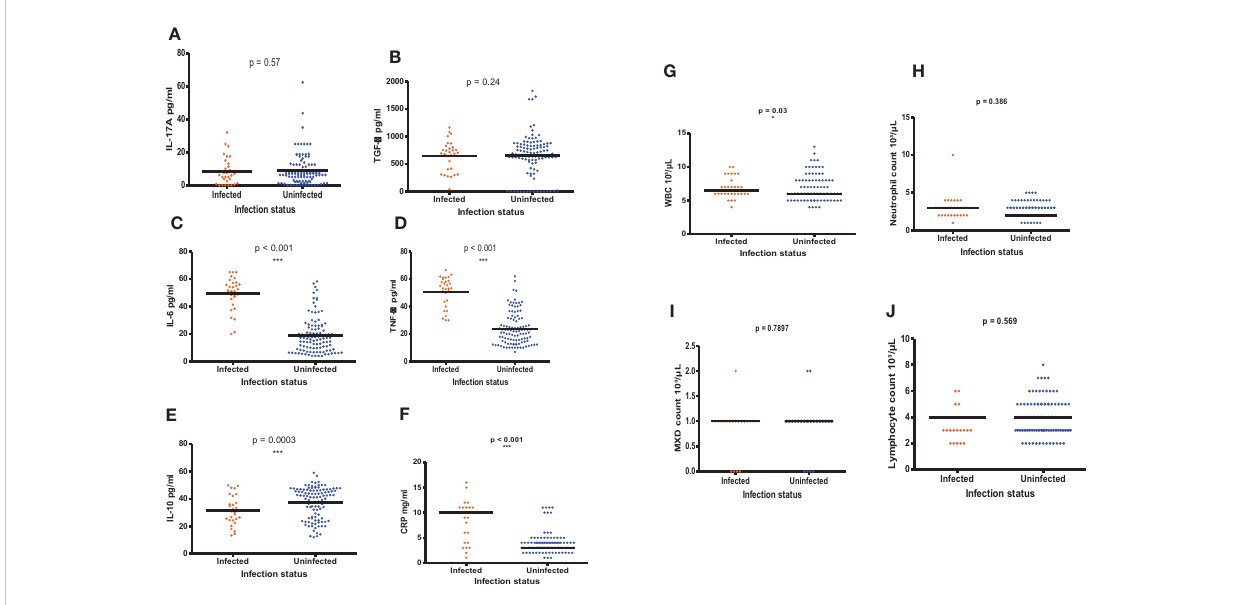
FIGURE 7 (A-J) Comparisons of the in fl ammatory biomarker levels in infected and uninfected PSAC using the Wilcoxon matched-pairs signed rank test. * = p ≤ 0.05, *** = p ≤